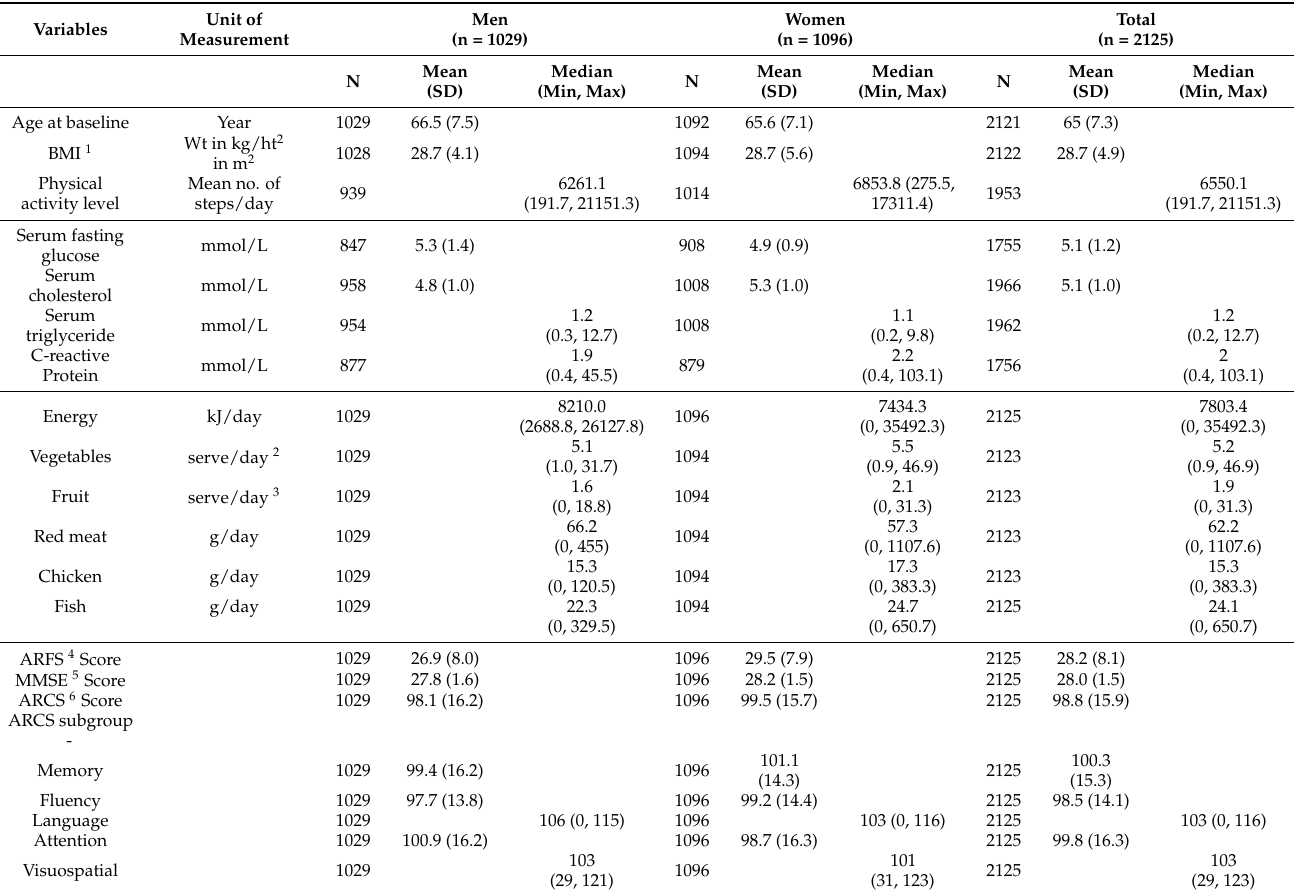
Table 1. Baseline characteristics for participants in the Hunter Community Study cohort of men and women aged 55–85